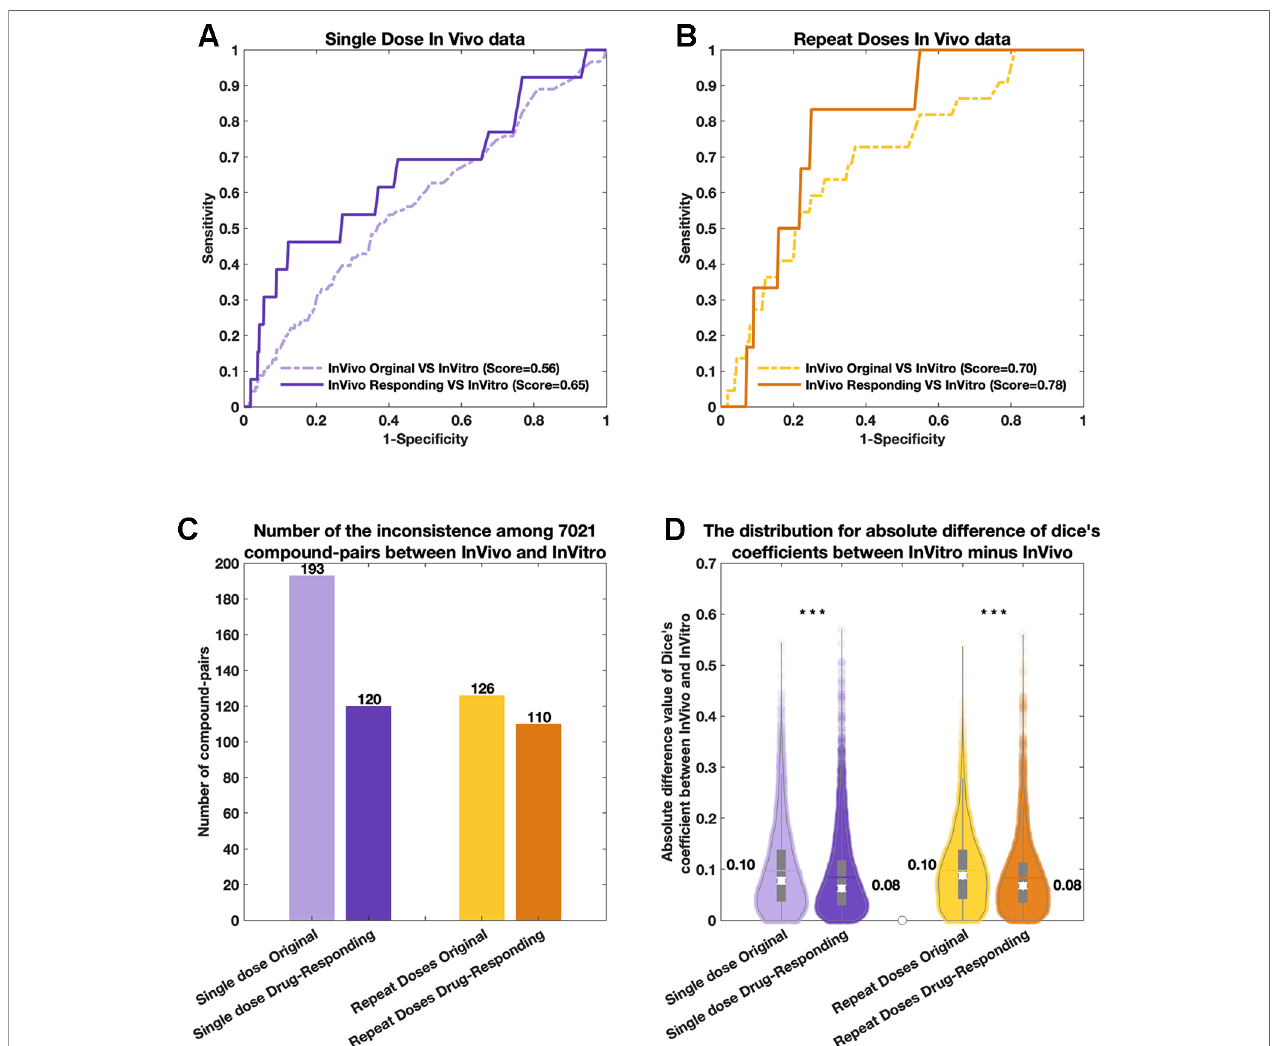
FIGURE 2 | The comparisons among original in vivo data, in vitro data, and the drug-responding component from the in vivo data. For all four subplots, purple represents the single-dose data, and yellow color represents the repeat-doses data. In the comparison with original in vivo data, the drug-responding component achieved higher consistencies based on both (A) a single dose and (B) repeat doses. (C) The comparison of the number of inconsistent compound-pairs between the in vivo and in vitro data among each system. (D) The violin plots of the absolute difference values between in vivo and in vitro (|Dice ’ s coef fi cient of in vivo data — Dice ’ s coef fi cient of in vitro data|)